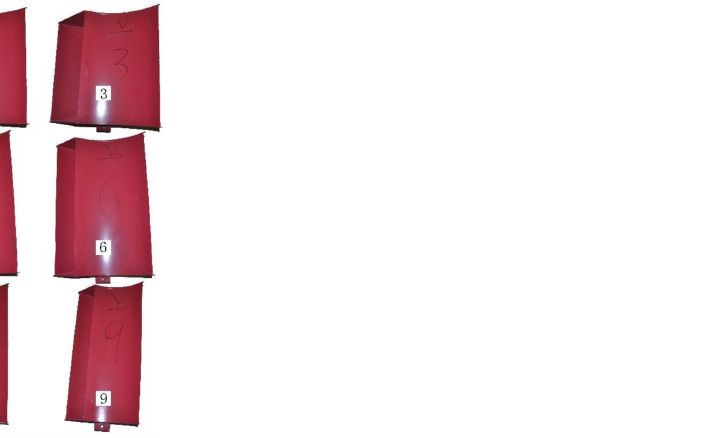
Figure 2. Nine otter board models: 1–9, corresponding to the numbers of nine otter board models in Table 3.